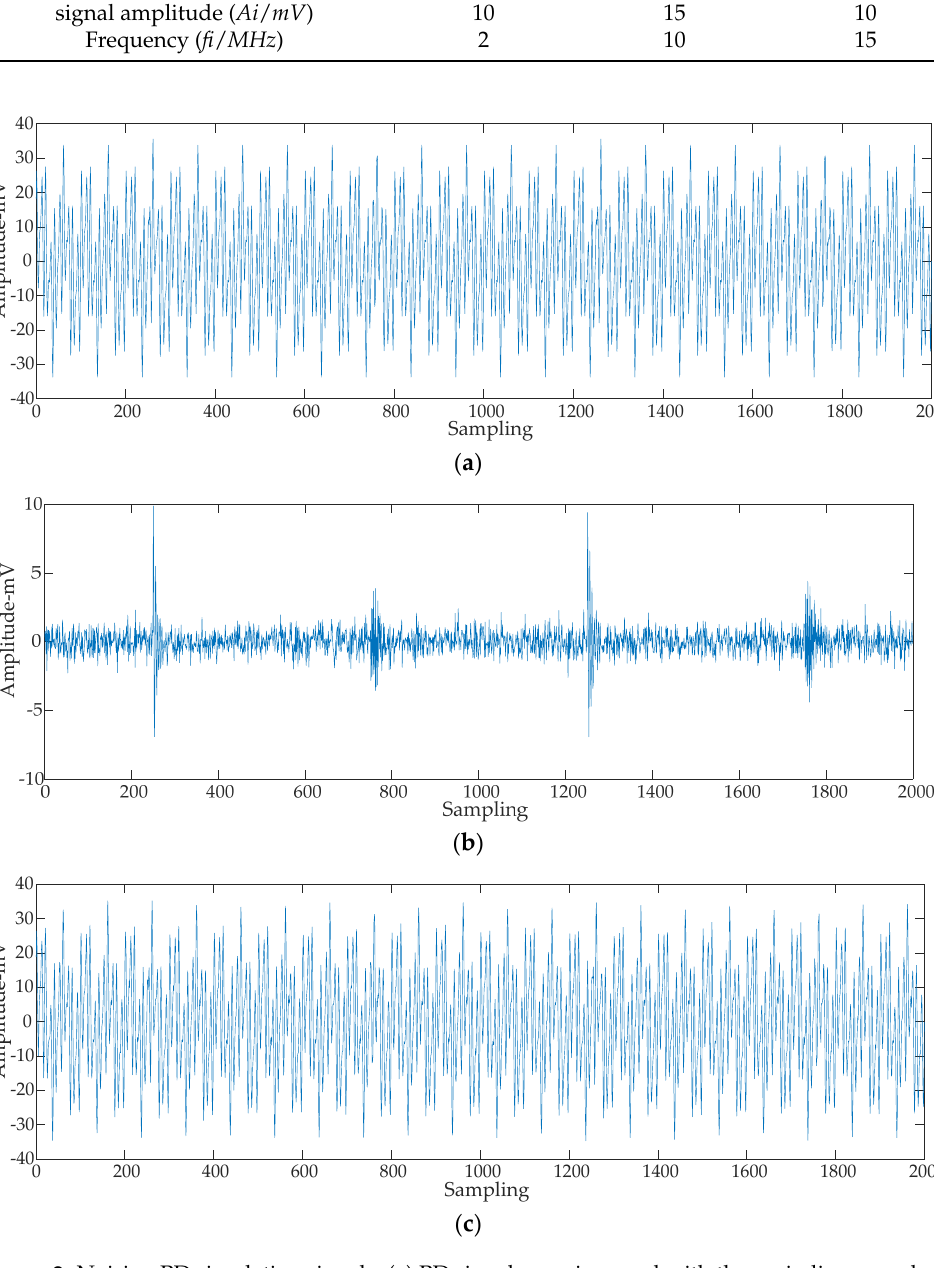
Figure 2. Noising PD simulation signals. ( a ) PD signal superimposed with the periodic narrowband interference signals. ( b ) PD signal superposition with white noise interference signal. ( c ) PD signal superposition with white noise and the periodic narrowband interference